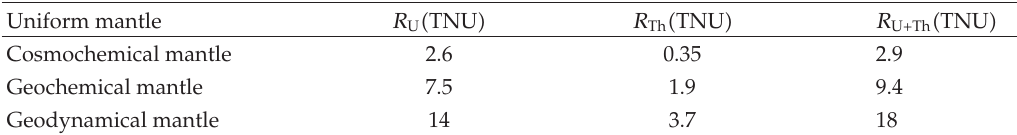
Table 8: Mantle geoneutrino signal in TNU predicted under the assumption of uniform distribution of U and